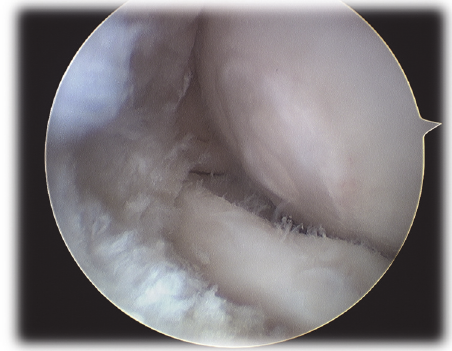
Figure 2: Arthroscopic finding of a type I ICRS capitellar cartilage lesion.